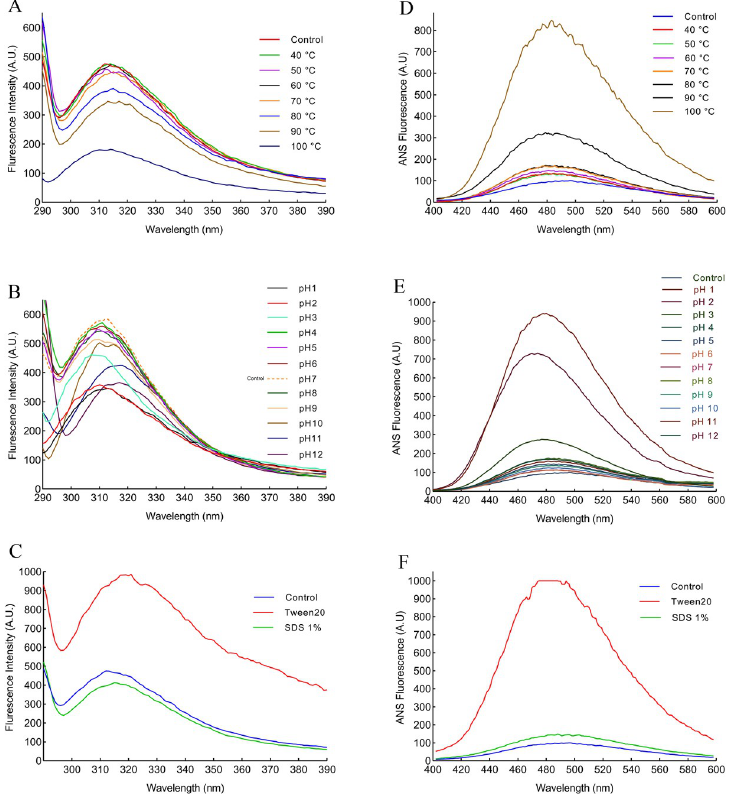
Fig 10. Intrinsic and extrinsic fluorescence spectroscopy of the protease 1147. (A) Intrinsic fluorescence spectroscopy of protease 1147 in the temperature range of 40–100˚C exhibited a decrease in fluorescence intensity in temperature higher than 80˚C and a blue shift in 100˚C. (B) Intrinsic fluorescence spectroscopy of protease 1147 in the pH range of 1–12 showed fluorescence decline in pH higher than 9 and lower than 3. A blue and red shift was observed in acidic and basic pH, respectively. (C) Intrinsic fluorescence spectroscopy of protease 1147 in the presence of 1% Tween 20 and SDS, indicated a slight reduction of fluorescence intensity for SDS and a huge increase and red shift for Tween 20. (D) Extrinsic fluorescence spectroscopy of protease 1147 in the temperature range of 40–100˚C exhibited a slight increase in fluorescence strength for temperature below 80˚C and a significant increase for 90 and 100˚C. (E) Extrinsic fluorescence spectroscopy of protease 1147 in the pH range of 1–12 showed huge fluctuation and blue shift of fluorescence strength in strongly acidic (pH 1–3) solution. (F) Extrinsic fluorescence spectroscopy of protease 1147 in the presence of 1% Tween 20 and SDS indicated a slight increase of fluorescence intensity for SDS and a huge increase for Tween 20.